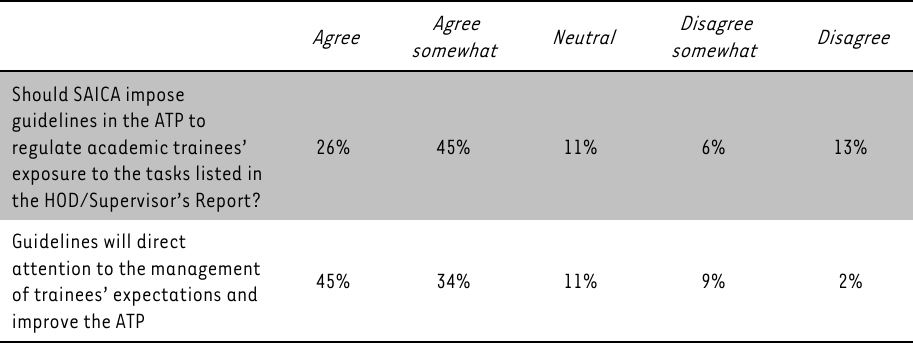
Guidelines in the ATP